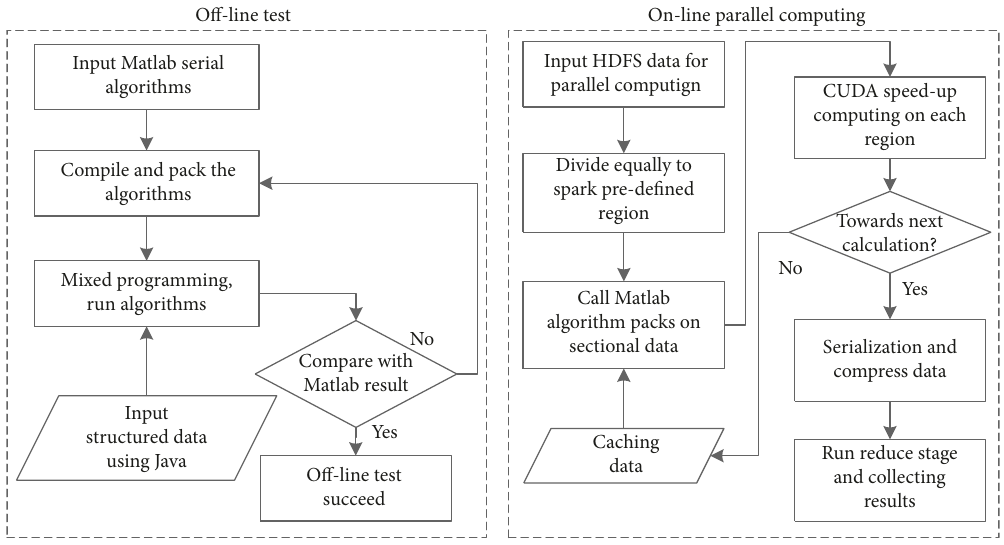
Figure 9: Fast-speed analysis fl owchart for CIM fi les. Table 6: The comparisons of parallel computing with single machine